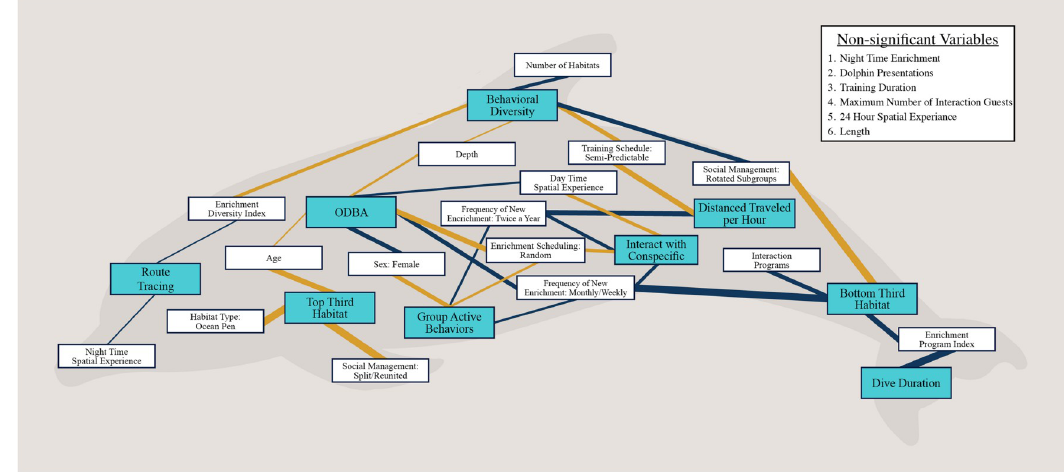
Fig 1. Welfare outcome and independent variable associations. Outcome variables are shown in blue boxes and independent variables are shown in white boxes (variables are defined in [27]). Positive correlations are represented with blue connecting lines and negative correlations are represented with yellow connecting lines. The strength of the relationship is indicated by the thickness of the connecting